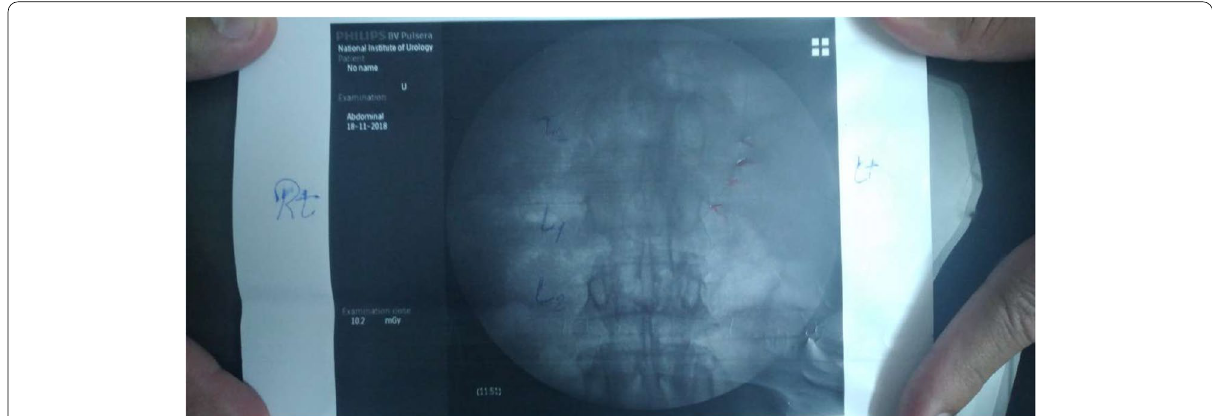
Fig. 1 Antero‑posterior image, showing the catheter on the left side with the tip coiled at the level of L1. The dye is noticed to be left‑sided, i.e., on the left side of vertebral spines